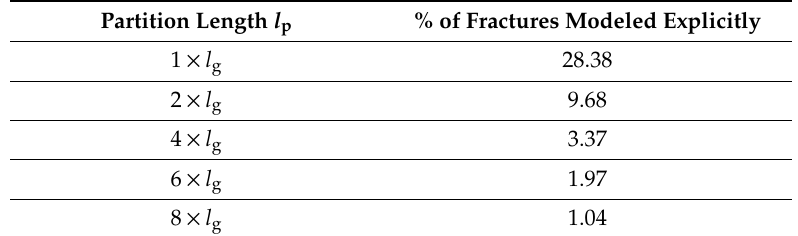
Table 3. Partition length for upscaling and the corresponding percentage of fractures modeled